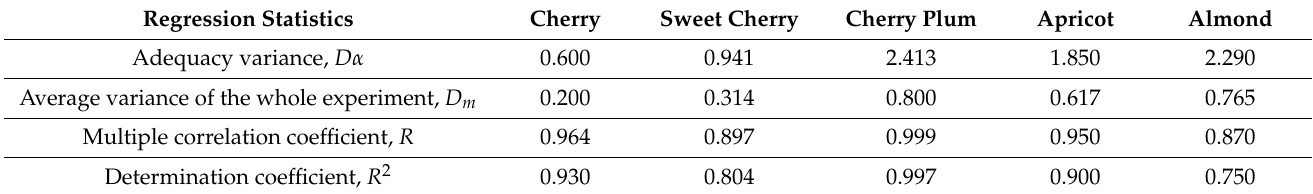
Table 3. Regression statistics of mathematical models of the process of sizing the bones of fruit